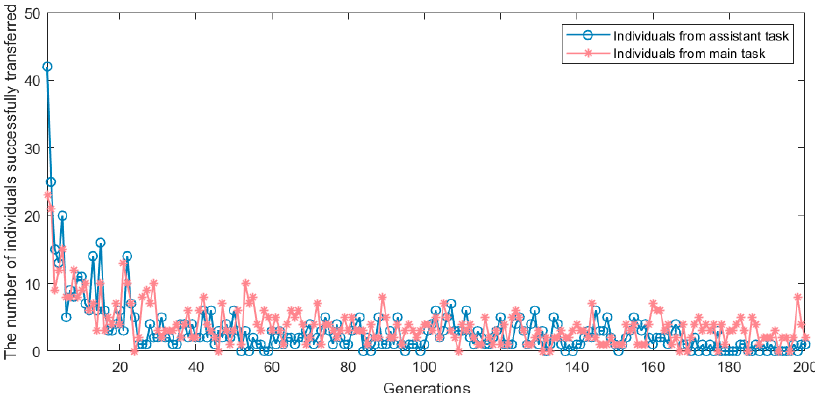
Figure 11. The number of individuals successfully transferred of